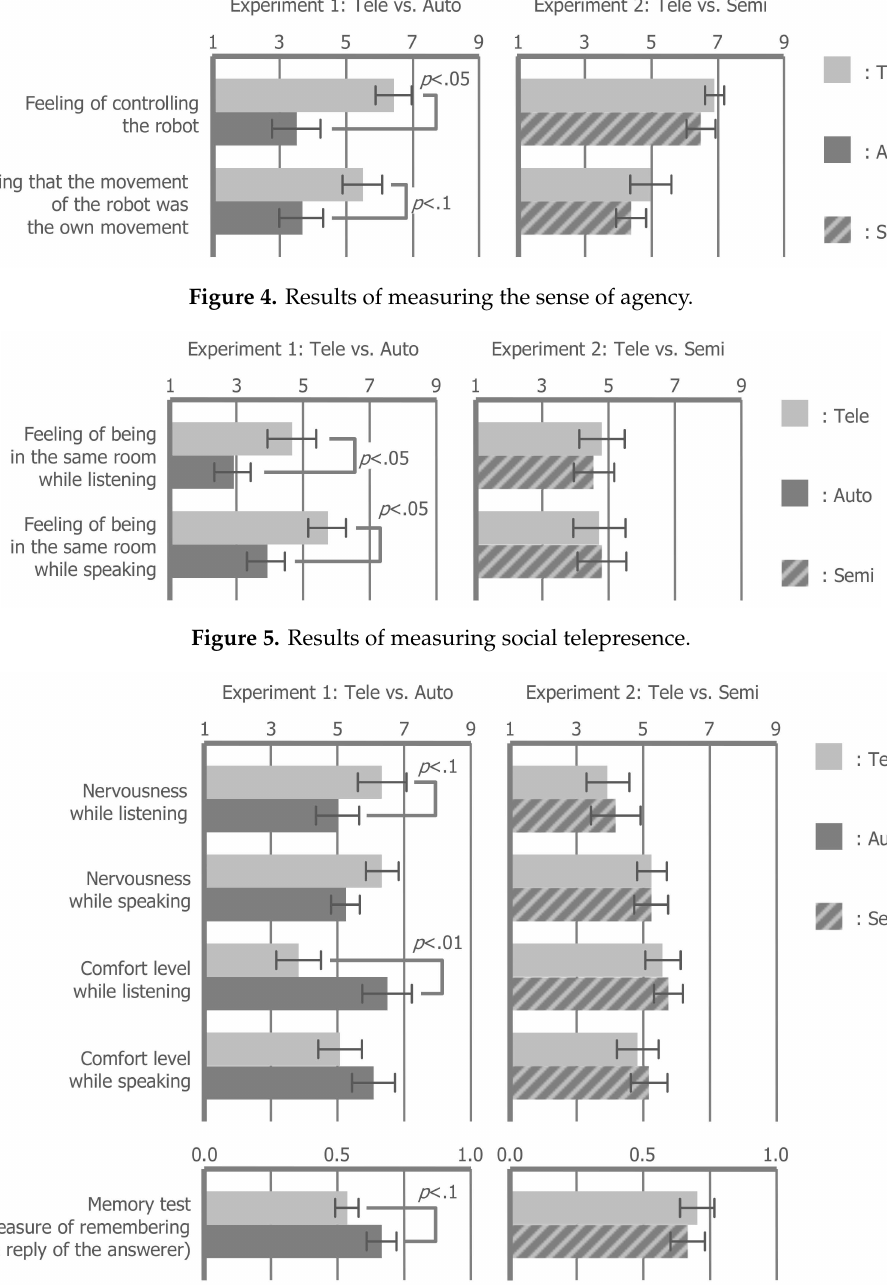
Figure 6. Results of measuring comfort